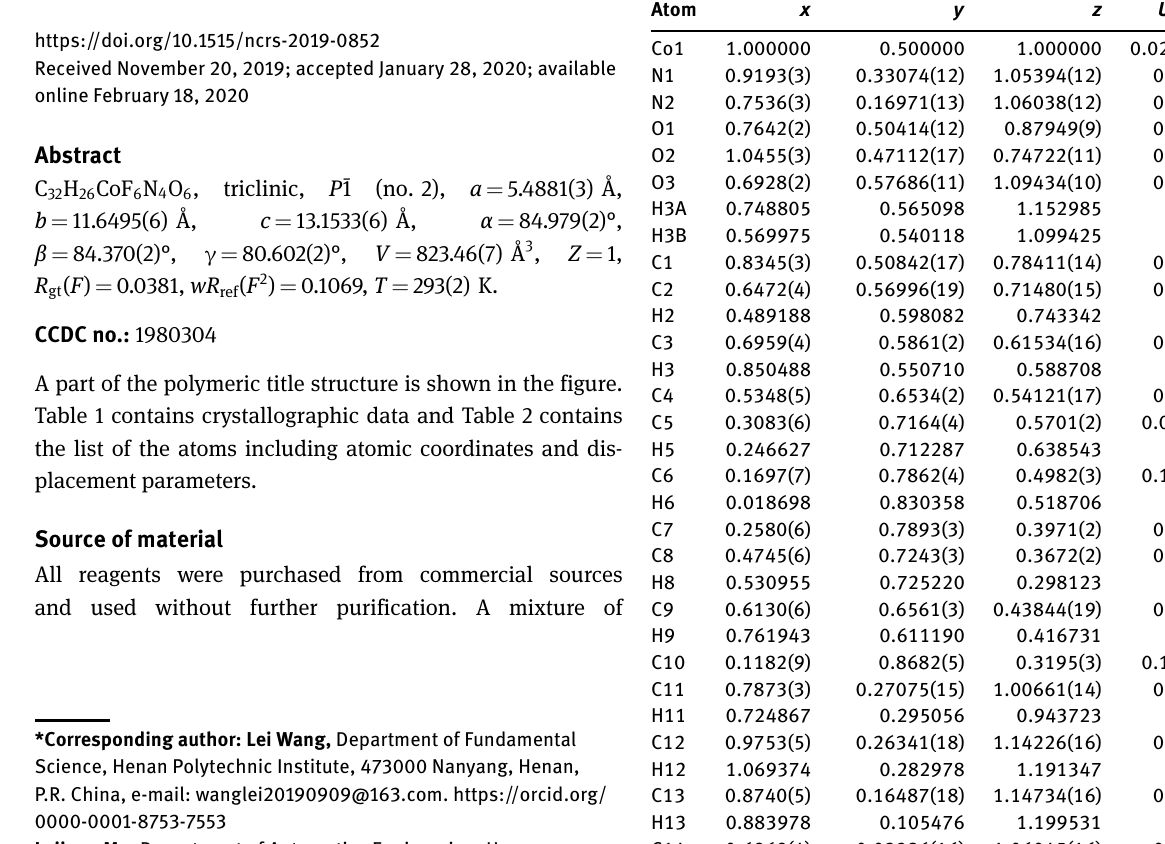
the list of the atoms including atomic coordinates and dis- placement parameters.